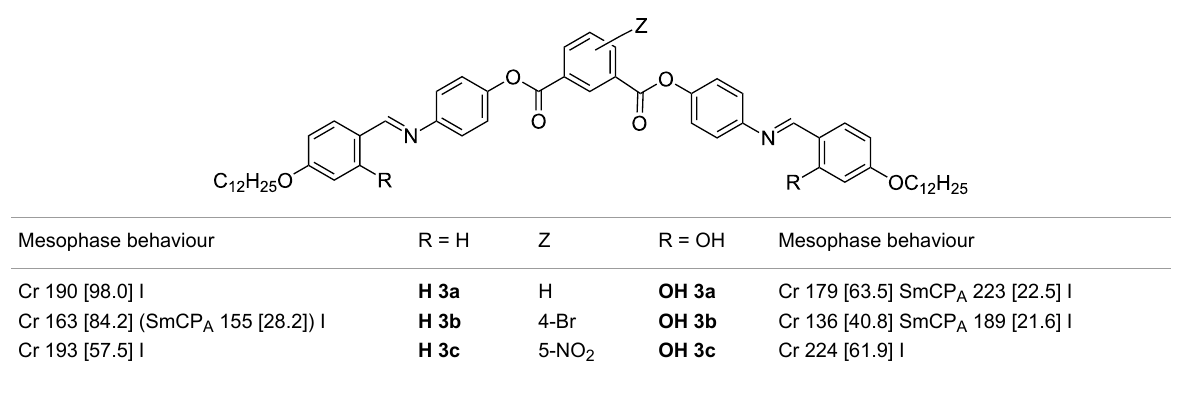
Table 3: Mesophase behaviour, transition temperatures (°C) and enthalpies [kJ/mol] of compounds OH 3 (on the right) and compounds H 3 (on the left).